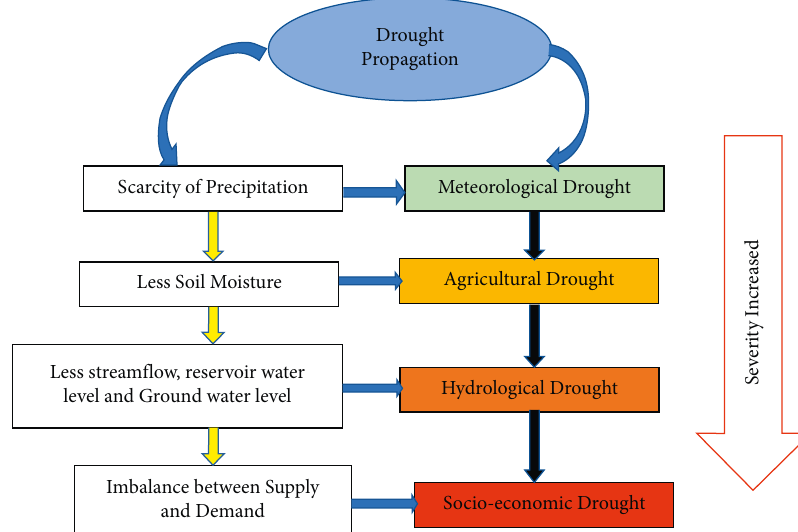
Figure 1: Relationship and propagation of different types of